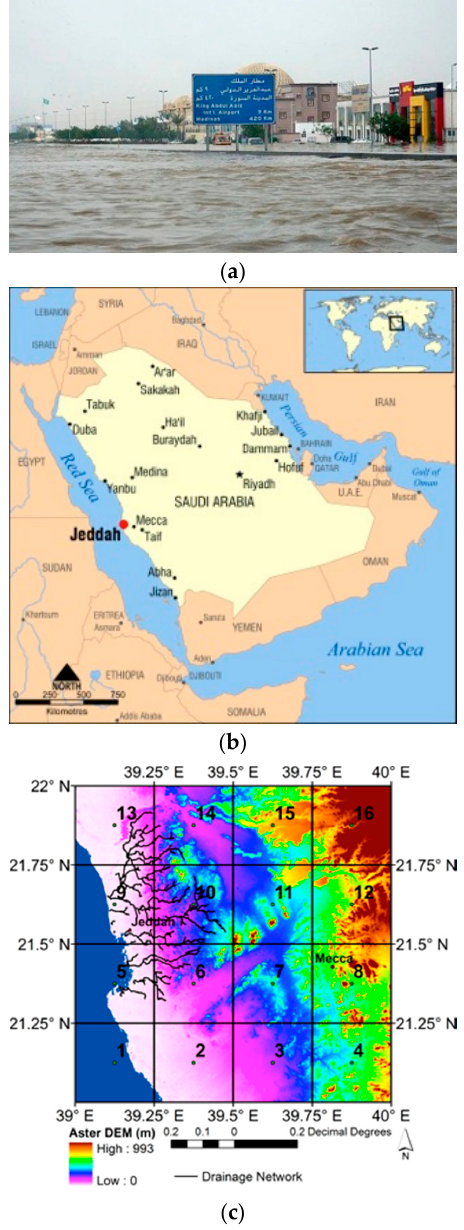
Figure 1. Flooding event in Jeddah from 24–26 November 2009 ( a ) Source: https://ontheredsea.wordpress.com/tag/jeddah/, location of Jeddah in KSA ( b ) Source: http://www.weather-forecast.com/system/images/249/original/Jeddah.jpg?1299372620, Digital Elevation Model of Jeddah city and surroundings obtained from ASTER DEM (30 m) ( c ).